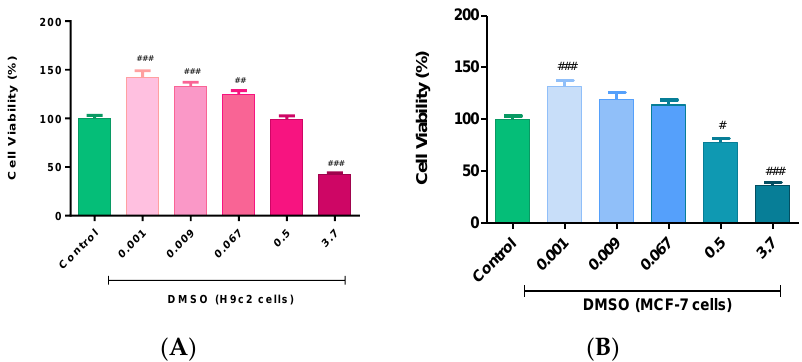
Figure 1. The effect of dimethyl sulfoxide (DMSO) on cell viability. An overview of the cytotoxicity effects of DMSO on the ( A ) H9c2 cardiomyoblasts and ( B ) MCF-7 breast cancer cells. Briefly, H9c2 and MCF-7 cells were treated with varying DMSO concentrations (0.001, 0.009, 0.067, 0.5, and 3.7%) every second day for 6 days. Untreated cells served as the control. Data are presented as the mean ± SEM of 3 biological experiments with 5 technical repeats ( n = 3). Significance is indicated as # p < 0.05, ## p < 0.01, and ### p < 0.001 versus the